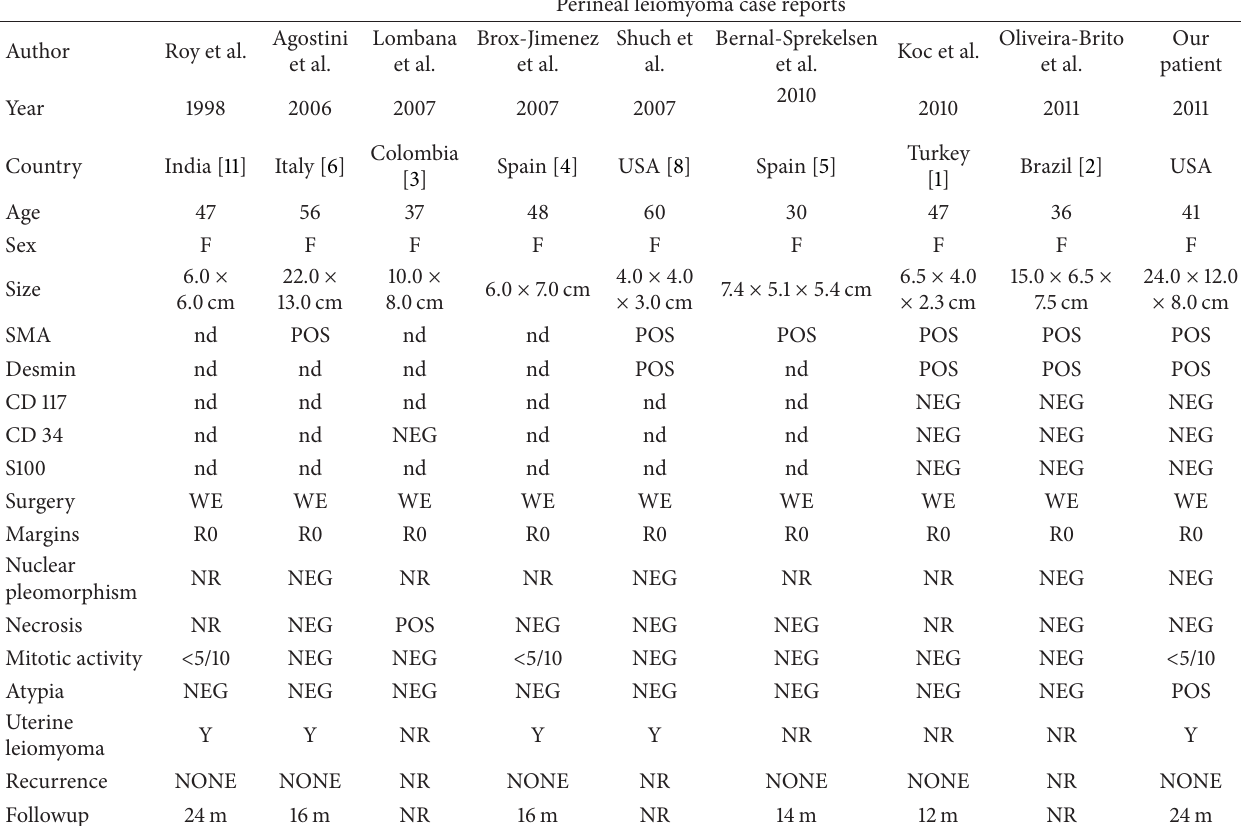
Table 2: Comparative table showing perineal leiomyoma case reports.